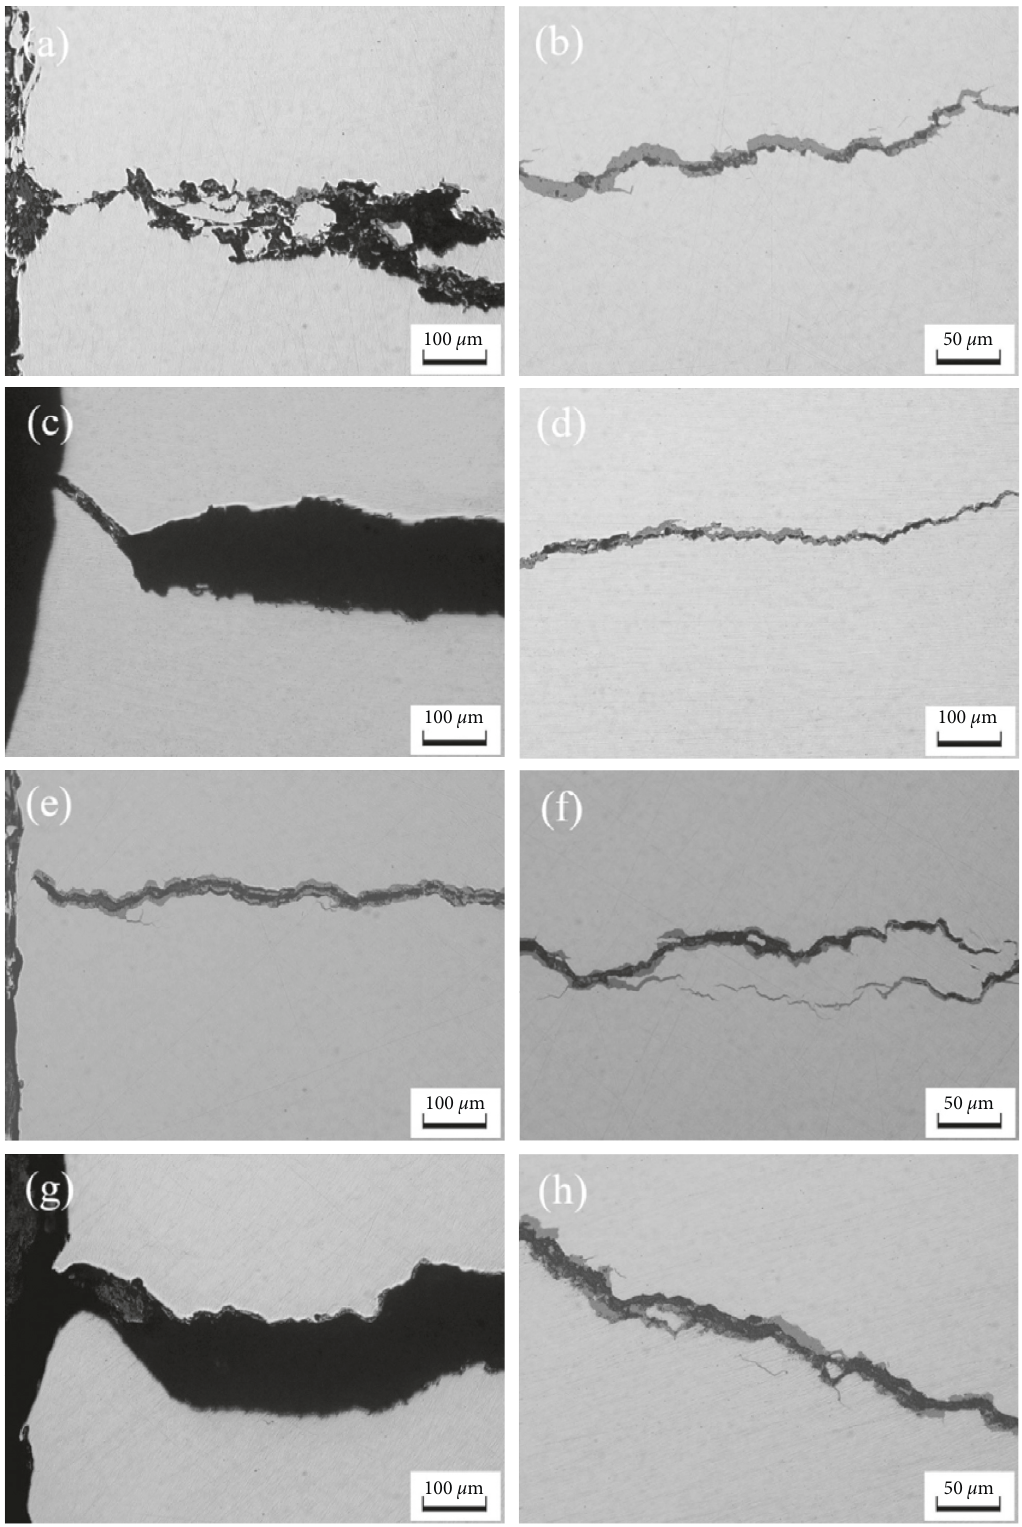
Figure 6: The crack morphology of samples and their end crack morphologies. (a) Crack morphology of sample X -1. (b) End crack morphology of sample X -1. (c) Crack morphology of sample X -3. (d) End crack morphology of sample X -3. (e) Crack morphology of sample Y -1. (f) End crack morphology of sample Y -1. (g) Crack morphology of sample Y -3. (h) End crack morphology of sample Y